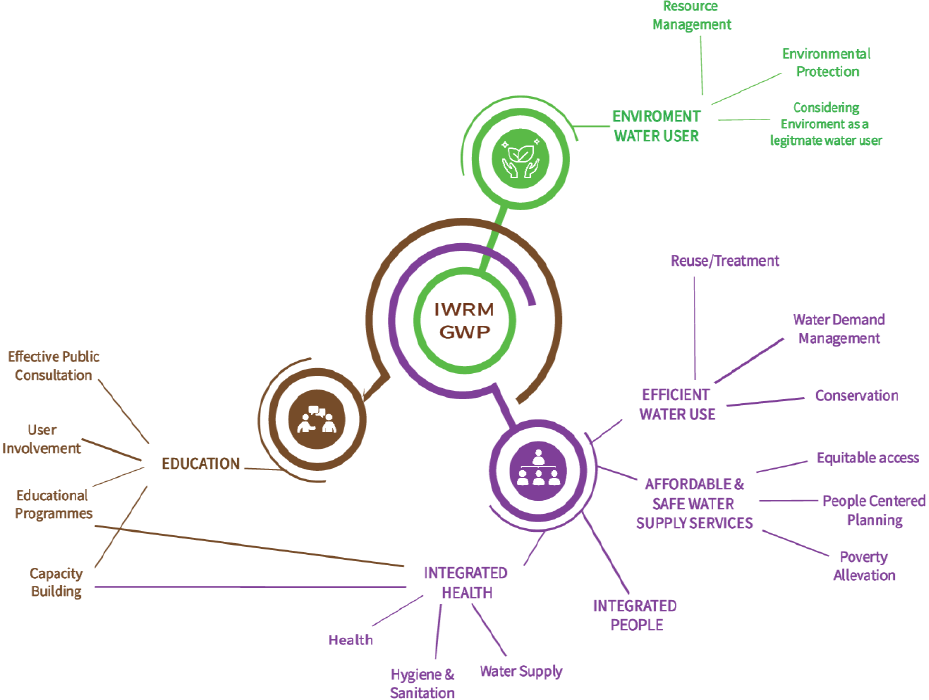
Figure 3. Integrated Water Resource Management–Global Water Partnership, International.